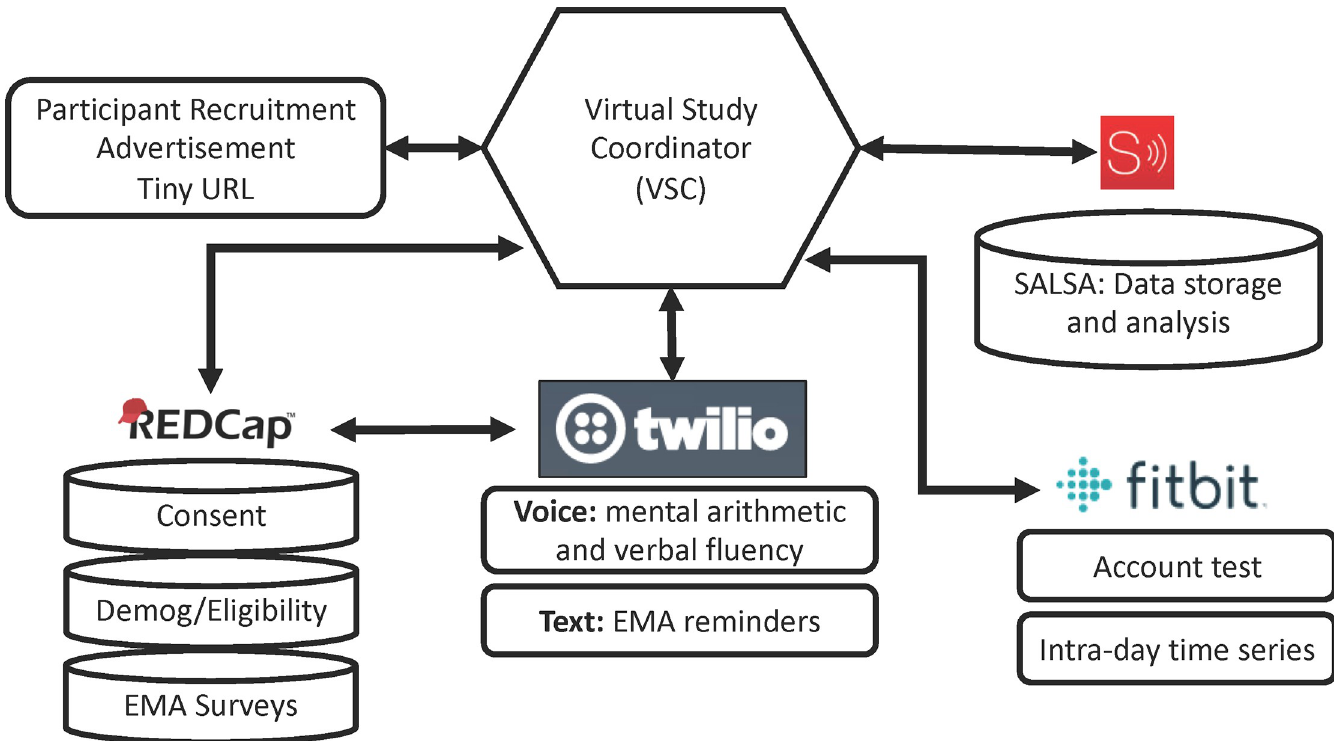
Fig 2. Infrastructure created to obtain and analyze data from wearable